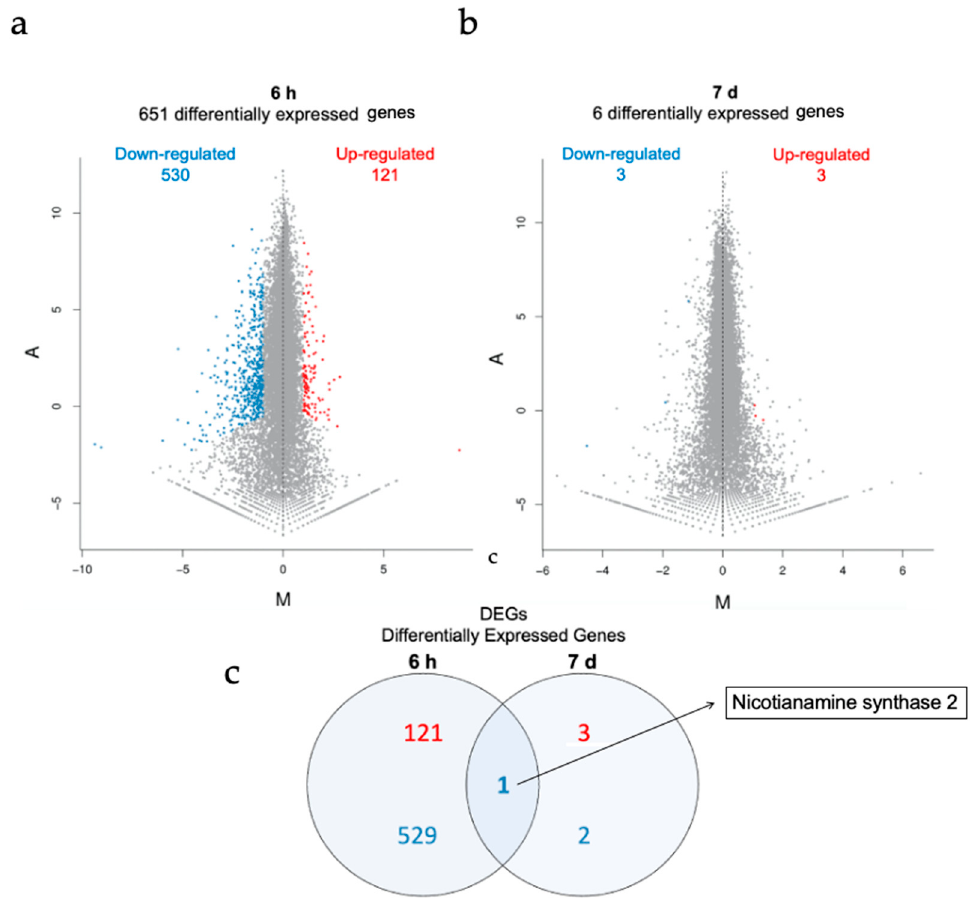
Figure 5. DEGs after AuNP-SCTA treatment. MA plot representing DEGs (upregulated genes: red dots; downregulated genes: blue dots) and non-DEGs (grey dots) in Arabidopsis seedling roots after ( a ) short- and ( b ) long-term AuNP-SCTA treatment (6 h and 7 d, respectively), detected by RNA-seq data analysis. The X-axis represents value M (log2 transformed fold change of a gene expression value) and the Y-axis represents value A (log2 transformed mean expression level). ( c ) Venn diagram displaying the total number of up- (red) and downregulated (blue) differentially expressed genes in both treatments and the name of the single overlapping